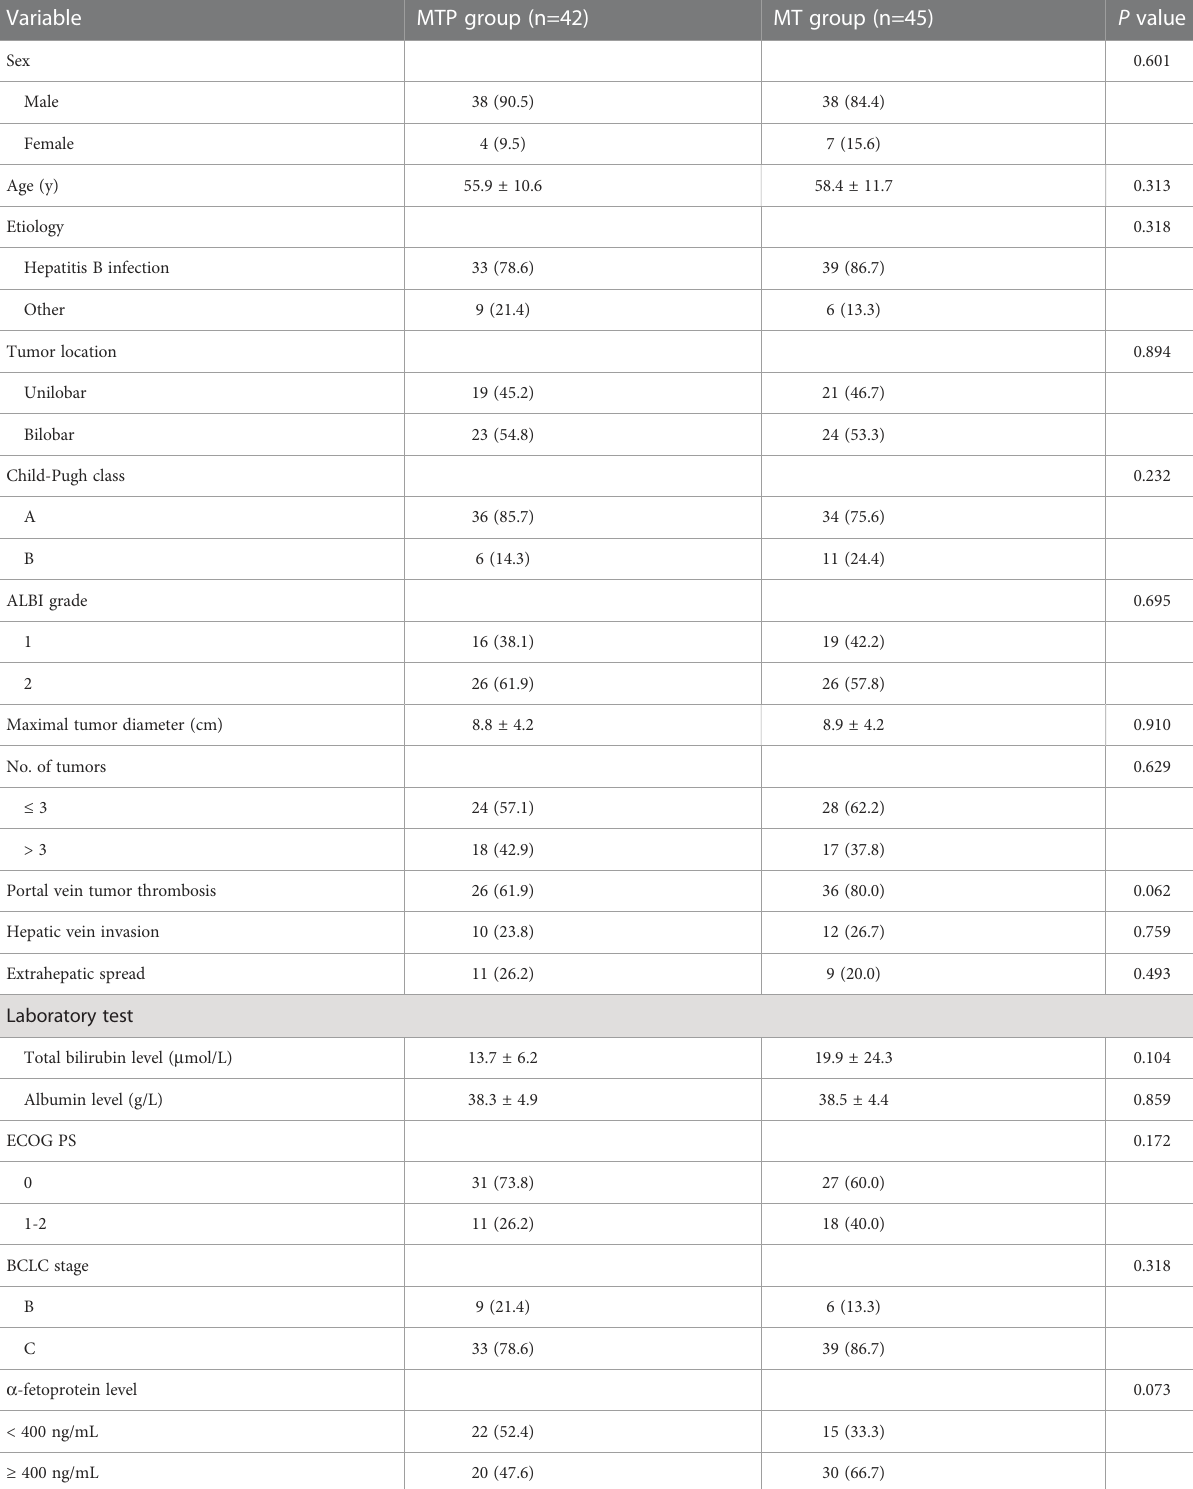
TABLE 1 Baseline Characteristics of all